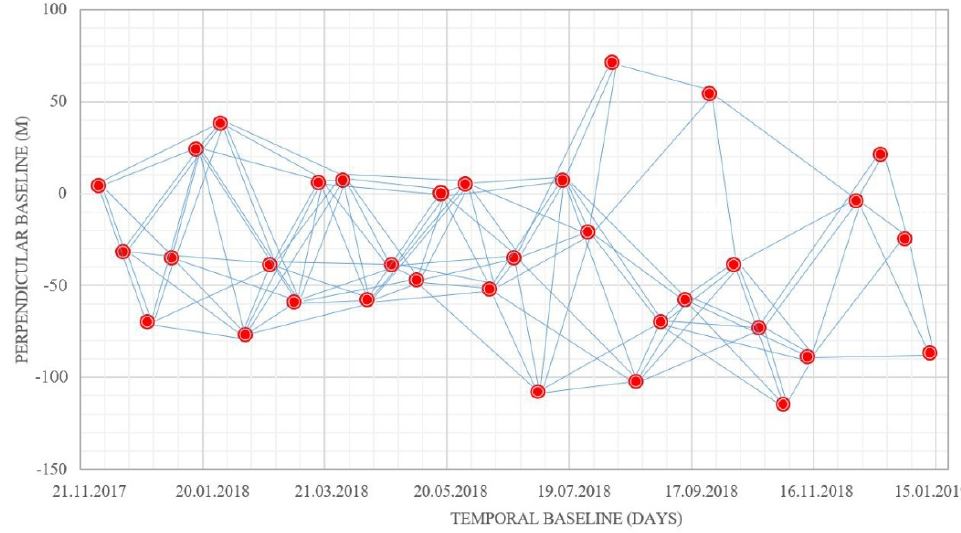
Figure 3. Temporal (x-axis) and perpendicular (y-axis) baseline of the Sentinel-1 acquisitions (red points). Individual SBAS interferogram pairs are shown by blue lines between every two differ- ent